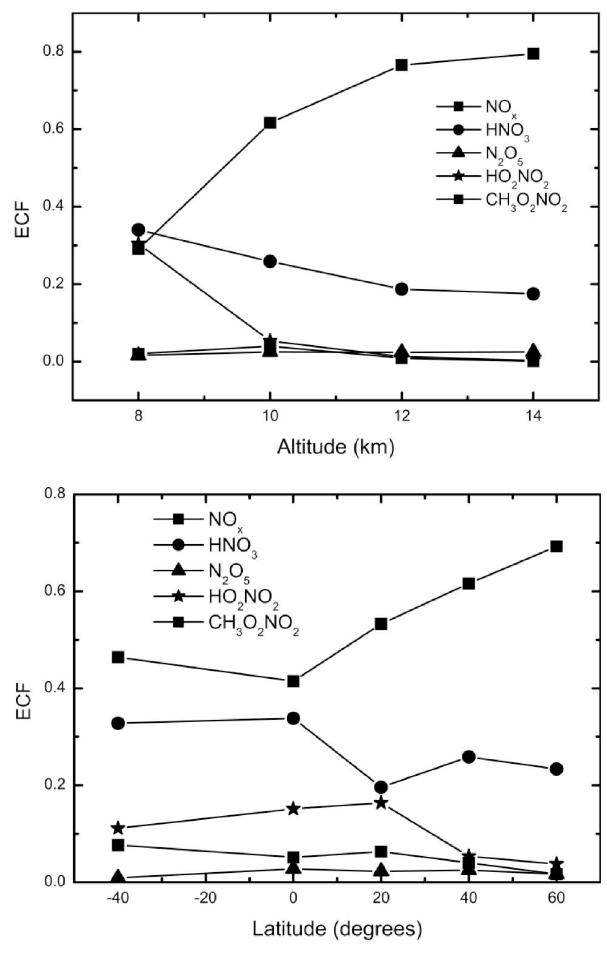
Fig. 15. Emission Conversion Factors for NO y species 24h af- ter emission (emission time 08:00LT) as functions of altitude (top panel) and latitude (bottom panel). Reprinted from Vohralik et al. (2008). An edited version of this paper was published by AGU. Copyright (2008) American Geophysical